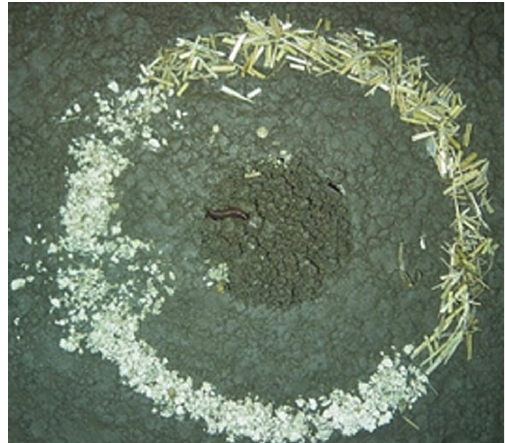
Figure 10: Results after one night of feeding by a single L. terrestris o ff ered equal amounts of barley straw and waste paper pulp in a 0.25 m 2 arena with the earthworm housed in a central cylinder of attached soil (from